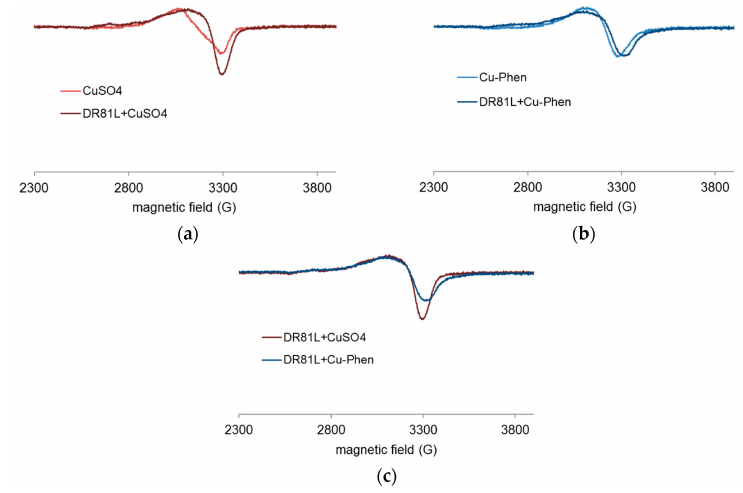
Figure 19. Experimental X-band EPR spectra recorded at 100 K in frozen aqueous solutions of ( a ) CuSO 4 and CuSO 4 + DR81 ( b ) Cu-Phen and Cu-Phen + DR81 ( c ) CuSO 4 + DR81 and Cu-Phen + DR81, at pH 6.5, with Cu:Phen molar ratio = 1:2, DR81:Cu molar ratio = 1:1.5 and [Cu] = 1.5